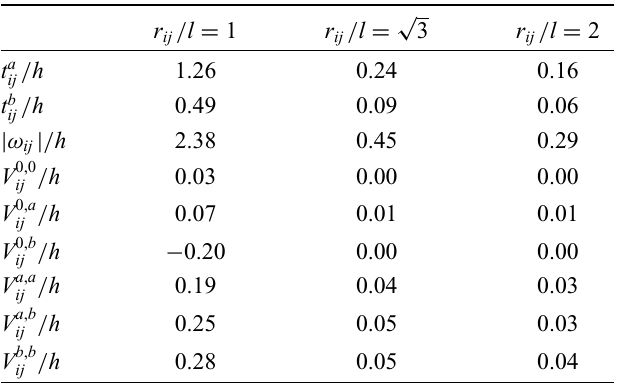
TABLE I. The hopping amplitudes and interactions up to next-next-nearest-neighbor hopping in megahertz. To avoid self- interaction in systems with periodic boundary conditions,